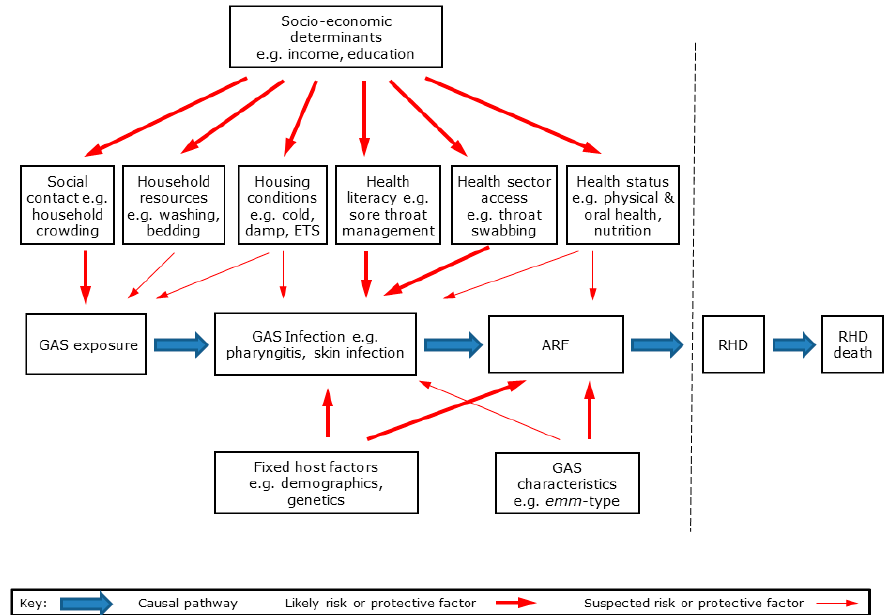
Figure 8. Causal pathway from GAS exposure to ARF and RHD showing major hypothesised groups of risk and protective factors.